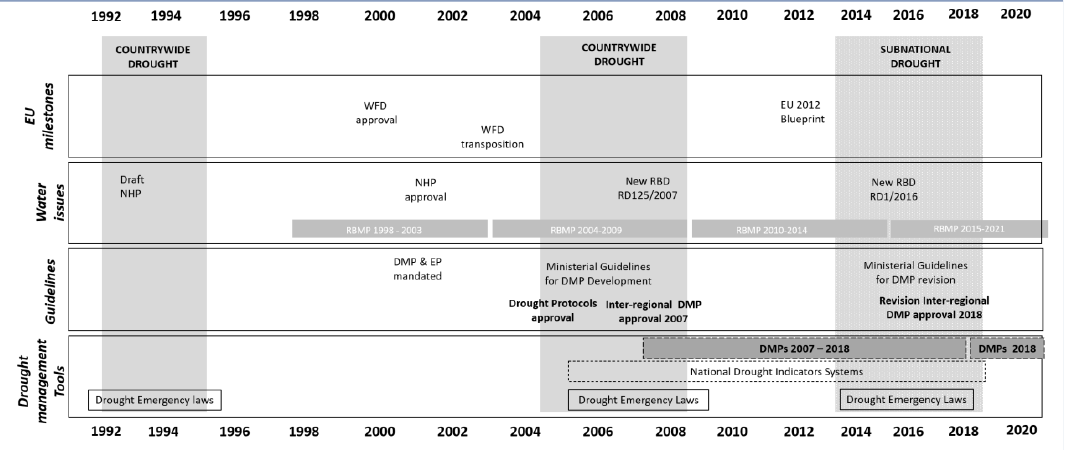
Figure 2. Timeline of the development of a drought management framework in Spain. Source. Adapted from Urquijo et al. [66].